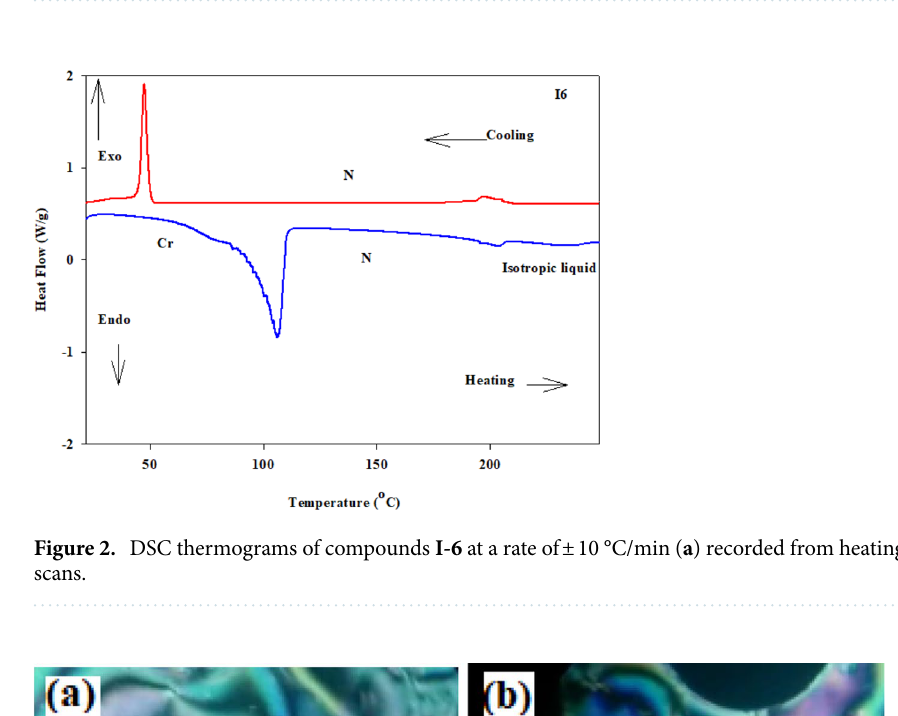
Figure 1. Synthesis route of title compounds I-n .